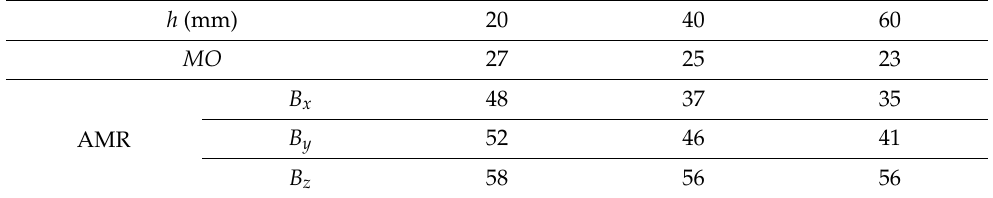
Table 3. Signal to noise ratio SNR calculated for measurements obtained by MO and AMR sensors for different concrete cover thicknesses h , and same pole